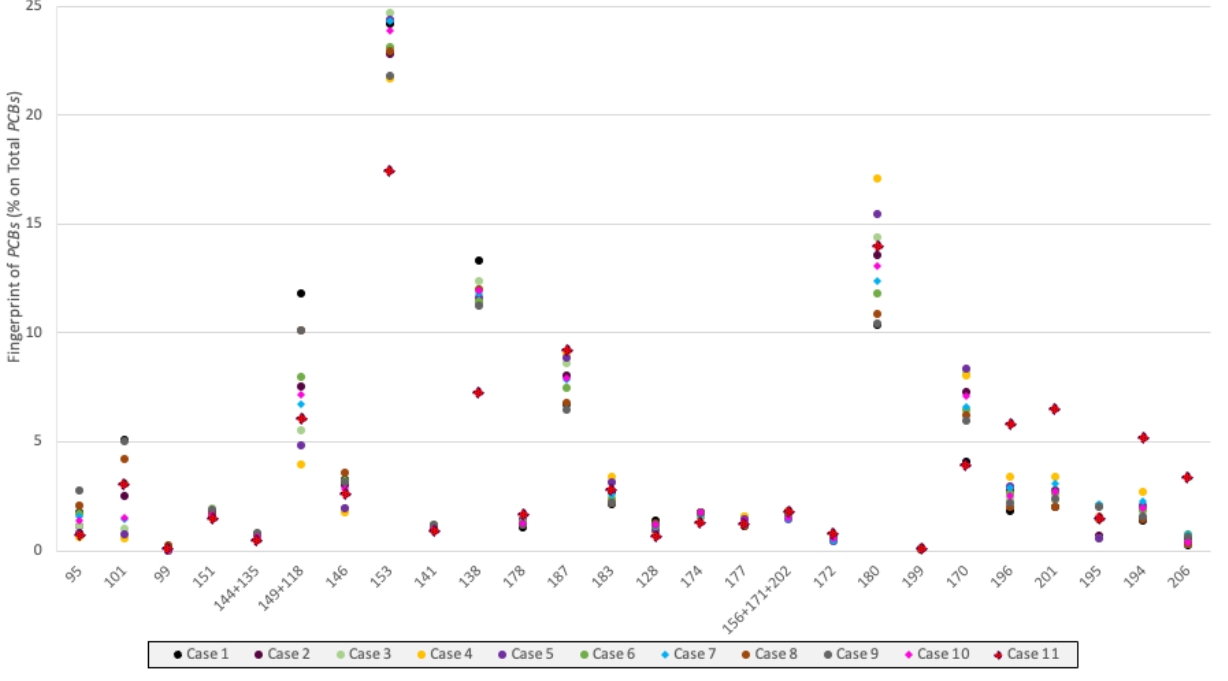
Figure 5. PCB fingerprint (% on Total PCBs) in the 11 specimens of bottlenose dolphin. The red dotted indicator point highlights the fingerprint of Case 11.